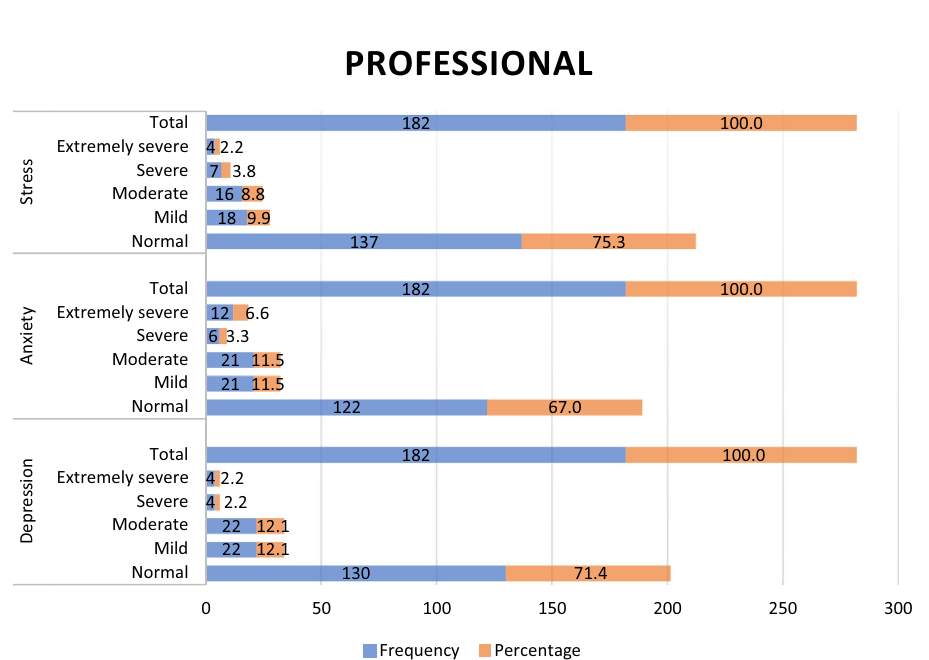
Figure 2. Distribution of dental professionals according to their levels of Depression, Anxiety and